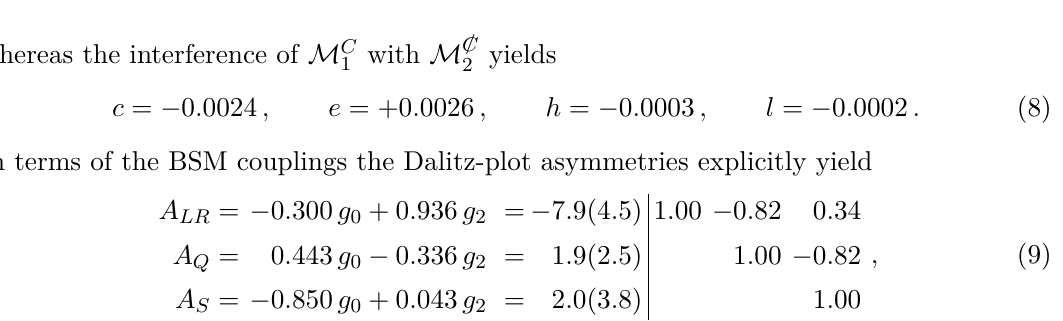
6 C C (bottom left) and 1 with M 0 M